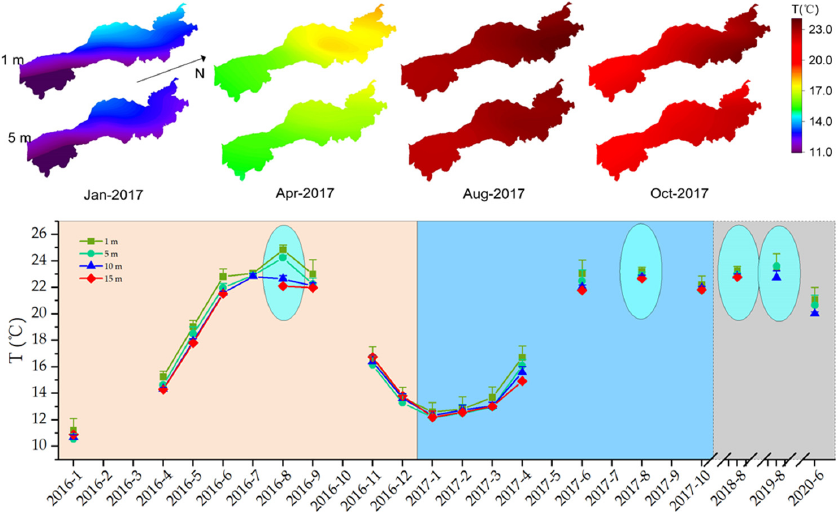
Figure 3. Spatiotemporal changes in T.